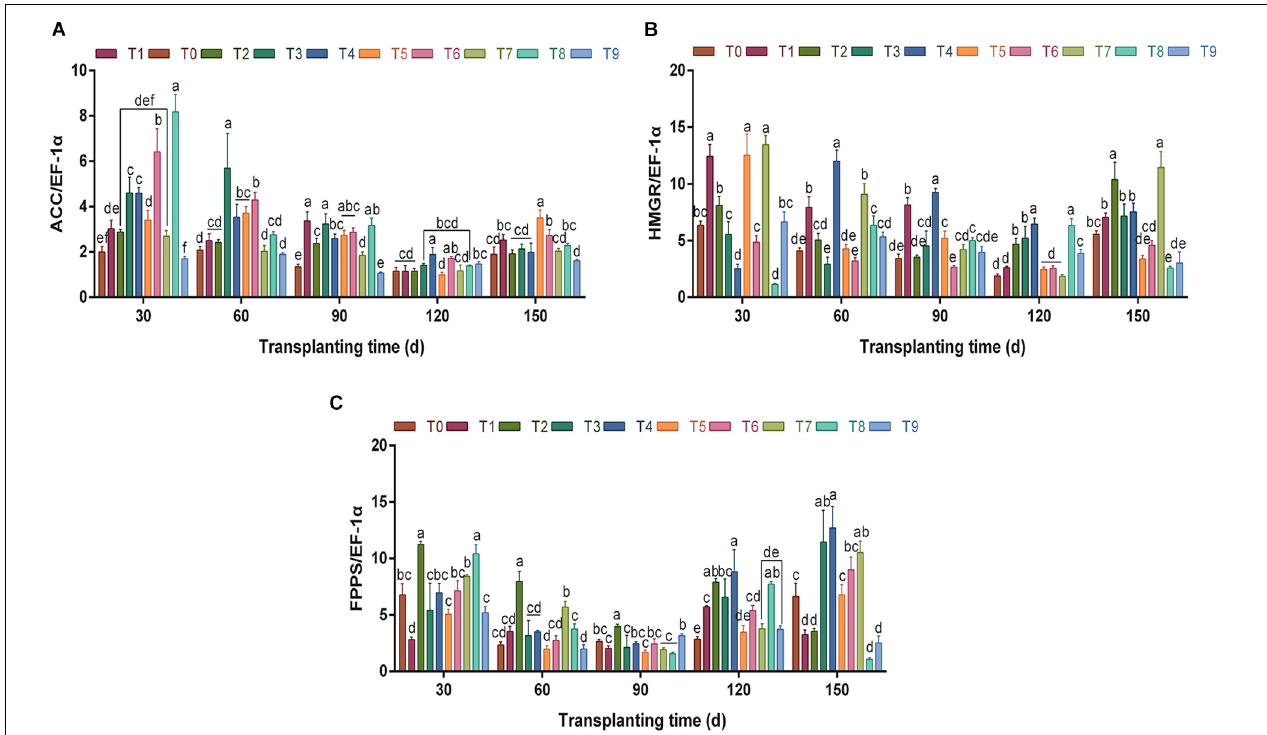
FIGURE 6 | The effects of different NPK combinations on the relative expression levels of key enzyme genes ACC (A) , HMGR (B) , and FPPS (C) in the rhizomes of A. chinensis ( n = 3). (a) The relative gene expression level is calculated based on the expression level of A. chinensis seedlings. (b) Different lowercase letters indicate that the effects of different NPK combinations on A. chinensis were significantly different in the same period ( p < 0.05). (c) The composition of fertilization treatments: T0,